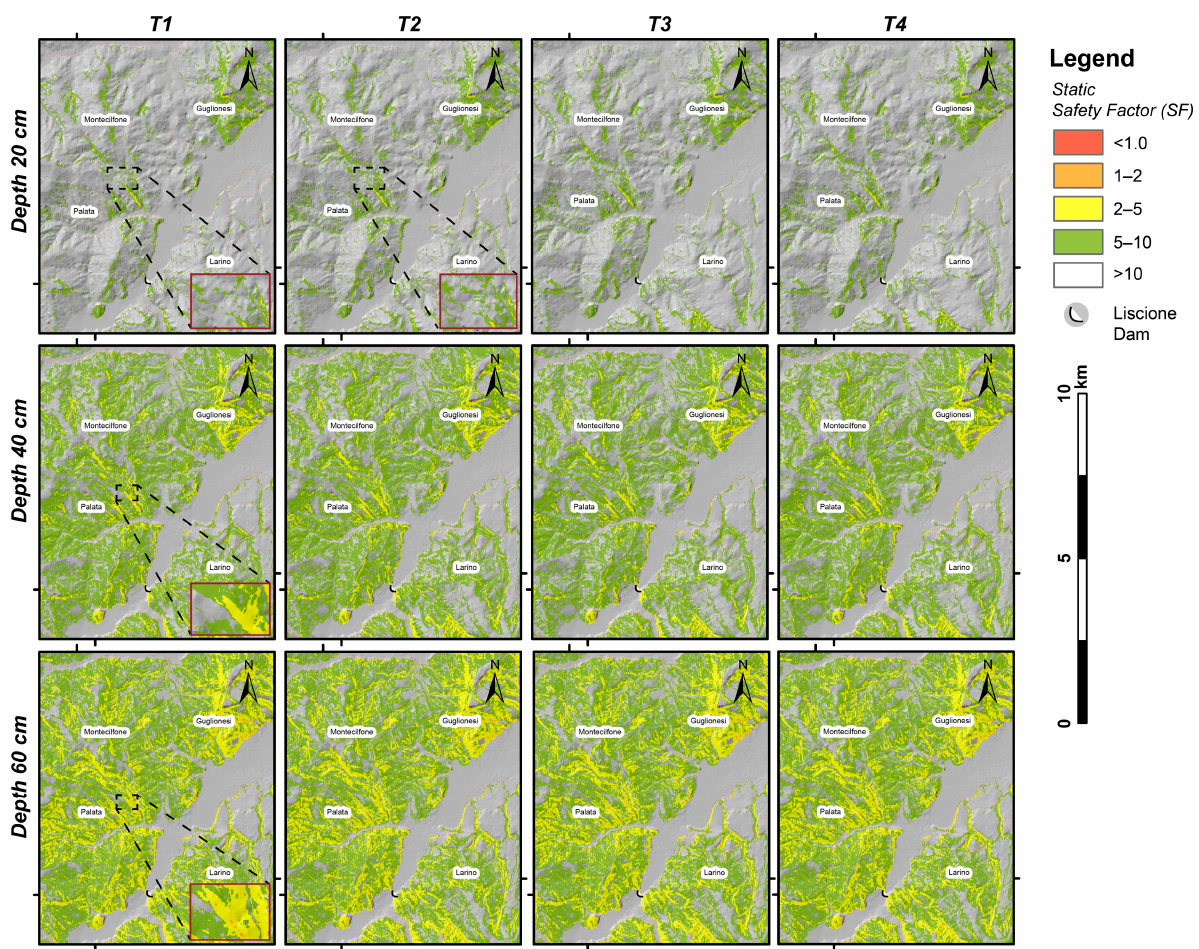
Figure 7. Maps showing the static SF at different depths over time within the shallow altered soil covers. The zoom boxes highlight the slight variation of SF factor in the surficial part of the covers with increasing both time and